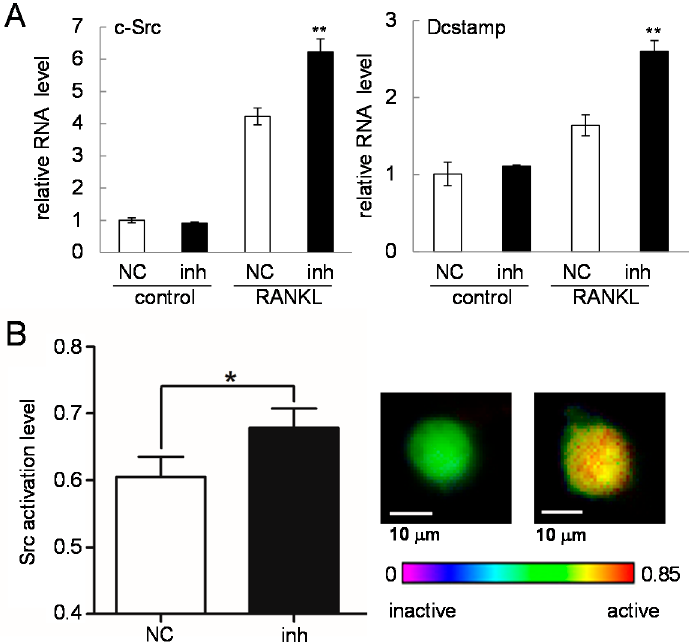
Figure 7. Responses of c-Src and Dcstamp to the inhibitor of miR-222-3p. Of note, 50 ng/mL RANKL was used for one day. The sample number was four in ( A ), and the scale bar is 10 µm in ( B ). NC = non-specific control; and inh = inhibitor of miR-222-3p. The single and double asterisks indicate p < 0.05 and p < 0.01, respectively. ( A ) c-Src and Dcstamp mRNA levels in response to the inhibitor of miR-222-3p; and ( B ) c-Src activity levels in response to the inhibitor of miR-222-3p.